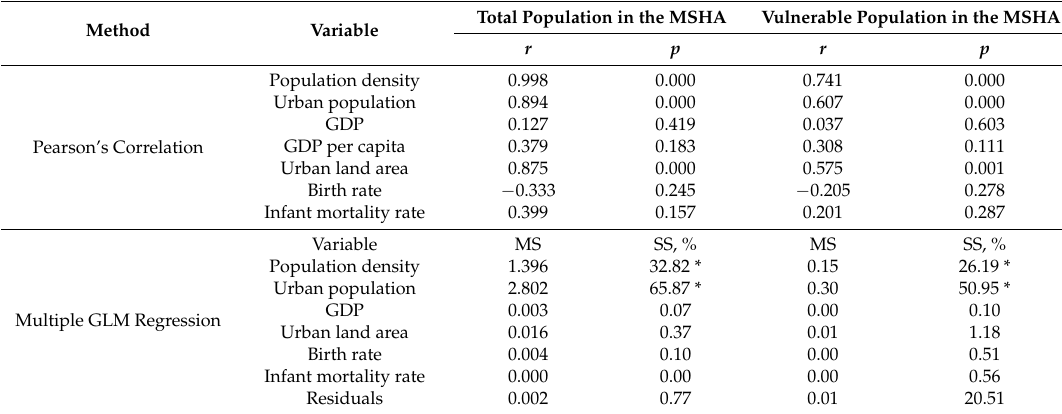
Table 4. Selected factors associated with population changes in the MSHA from 2000 to 2015. Total Population in the MSHA Vulnerable Population in the MSHA Method Variable r p r p Population density Pearson’s Correlation